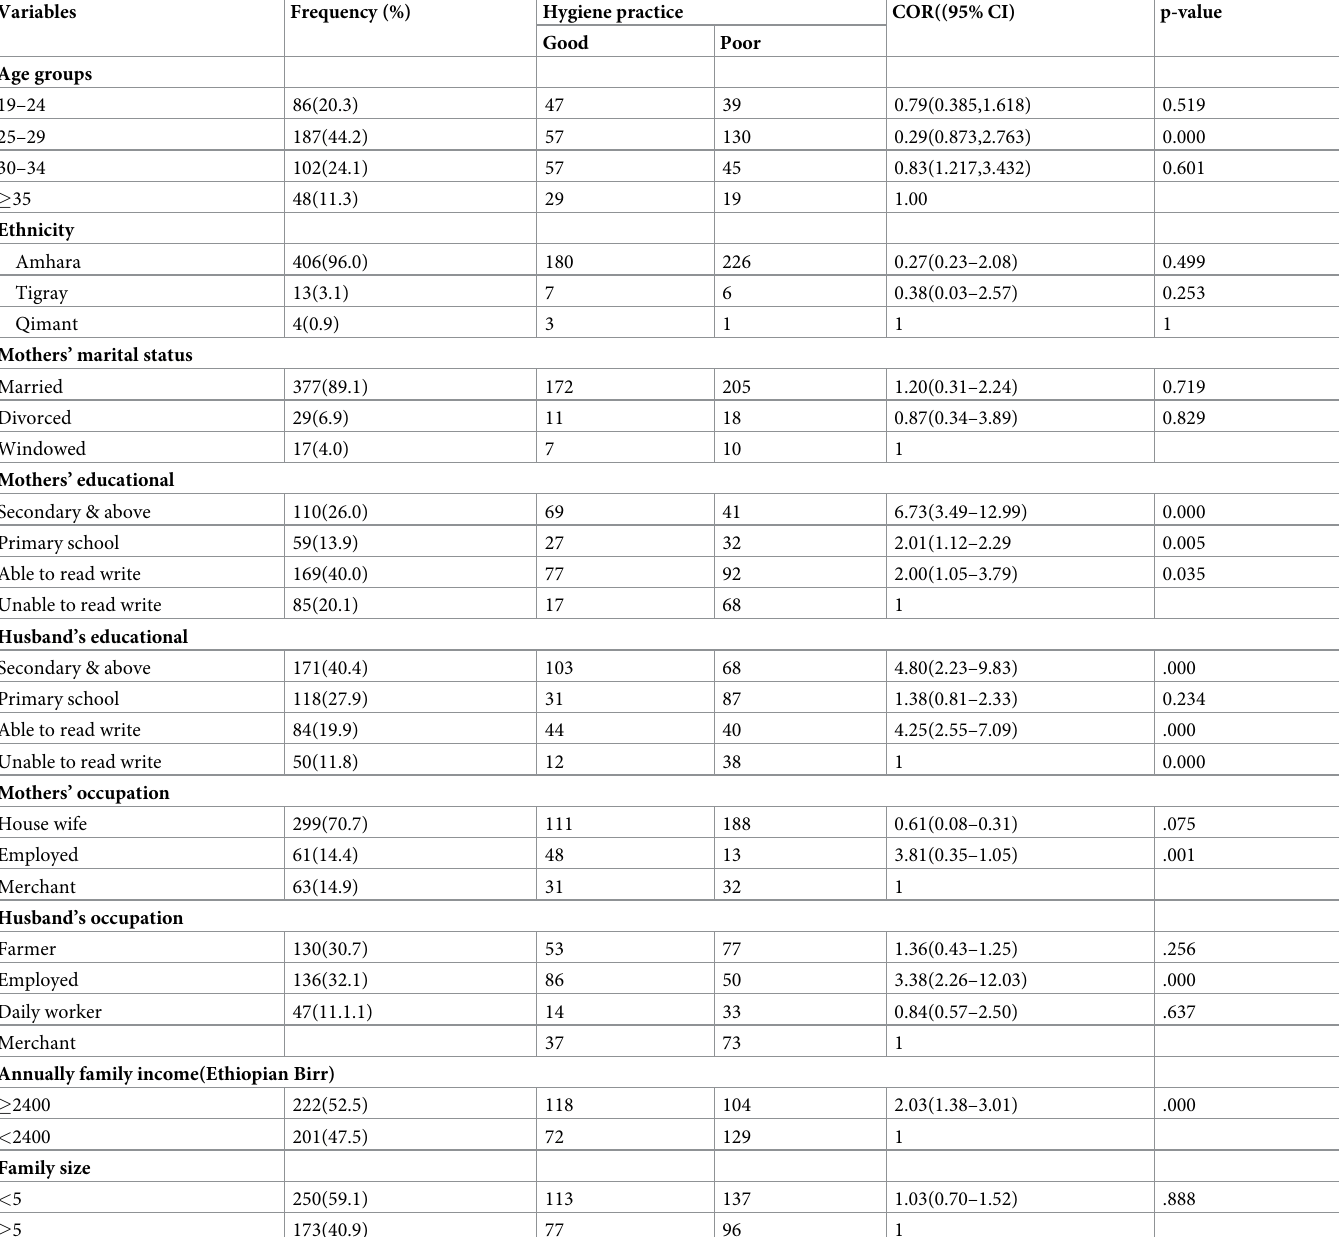
Table 2. Bivariate analysis of the association of socio-demographic factors with hygiene practice during complementary food preparation among mothers with 6–24 months aged of children in Debark town, Ethiopia,